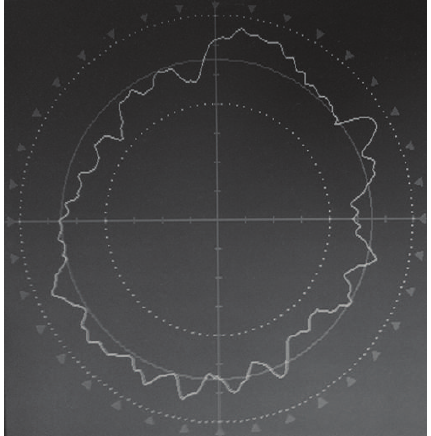
Figure 6: Out-of-roundness measurement results on premachined S355J2 steel. Ra3.5 and PV value 24.2 𝜇 m.